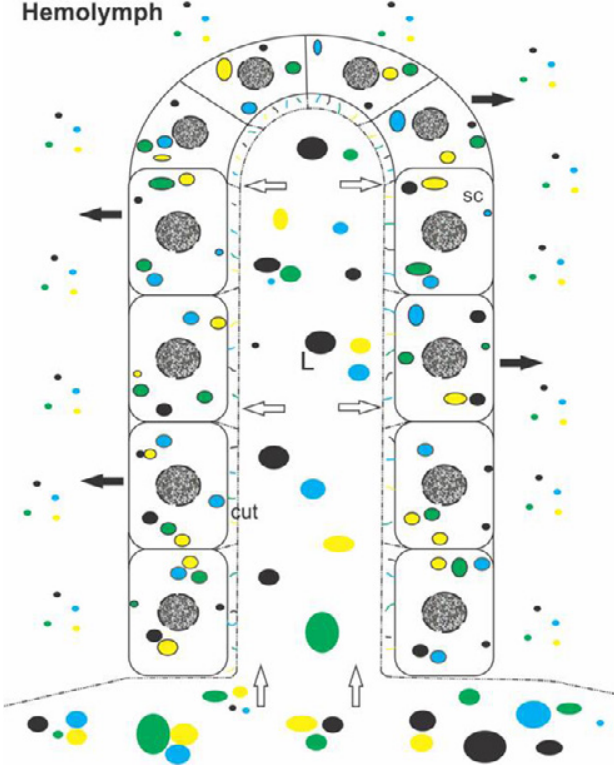
Fig 4 . Schematic representation of lipid mobilization from the postpharyngeal gland (PPG) to the hemolymph after lipid supplementation in the leaf-cutting ant Atta sexdens rubropilosa . Lipids from the diet are forwarded (white arrow) to the lumen (L) of a digitiform prolongation in the PPG and arrive at the secretory cell (SC) after crossing the cuticle (cut). Once inside the cell, lipids are mobilized (black arrow) to the hemolymph. Fatty acids identified by GC-MS are shown as colored ovals: C16, green; C18, yellow; C18:1, blue; C18:2, black. Oval size is proportional to the amount of fatty acid detected.